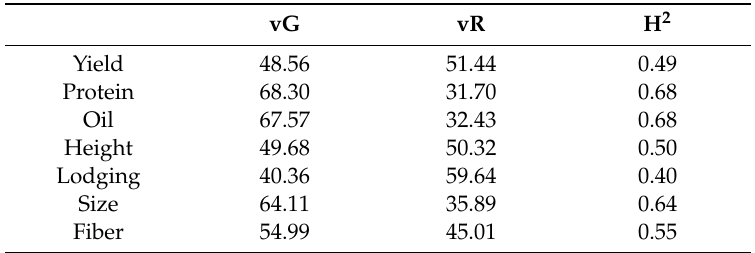
Table 2. Percentage of phenotypic variability captured with the genomic (G) and residual terms (R) of model M1, and the broad sense genomic heritability (H 2 ). The variance components were computed for 7 traits from a Nested Association Mapping population (SOYNAM) comprising information of 2560 genotypes belonging to 40 bi-parental families tested in Nebraska in